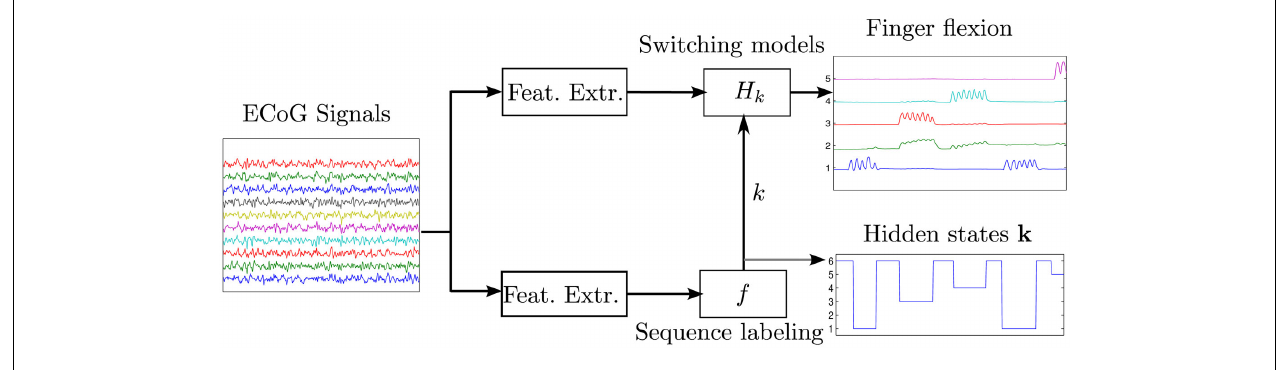
FIGURE 1 | Diagram of the switching models decoder. We see that two models ares estimated from the ECoG signals: (bottom flow) one which